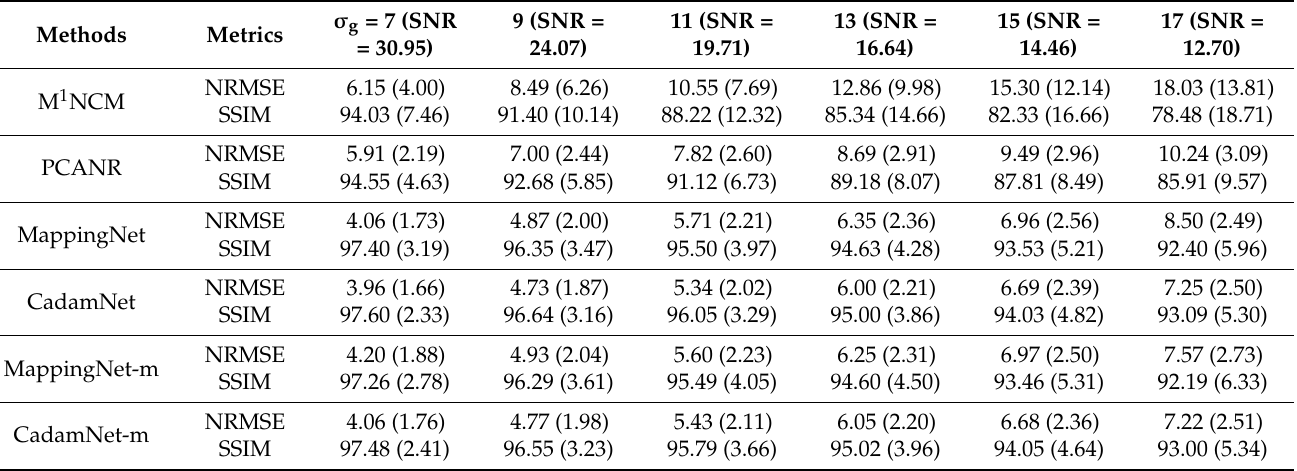
Table 1. The NRMSE (%) and SSIM (%) measures of different methods on simulated testing datasets with various noise standard deviations ( σ g ).